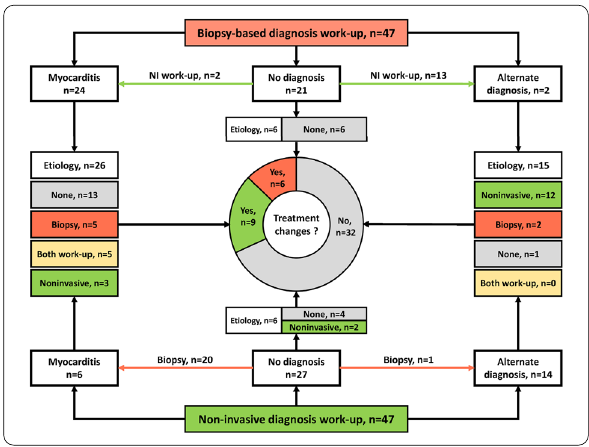
FC‑031 Stent thrombosis in cardiac arrest patients: prevalence, risk factors and long‑term outcome BOIS Antoine